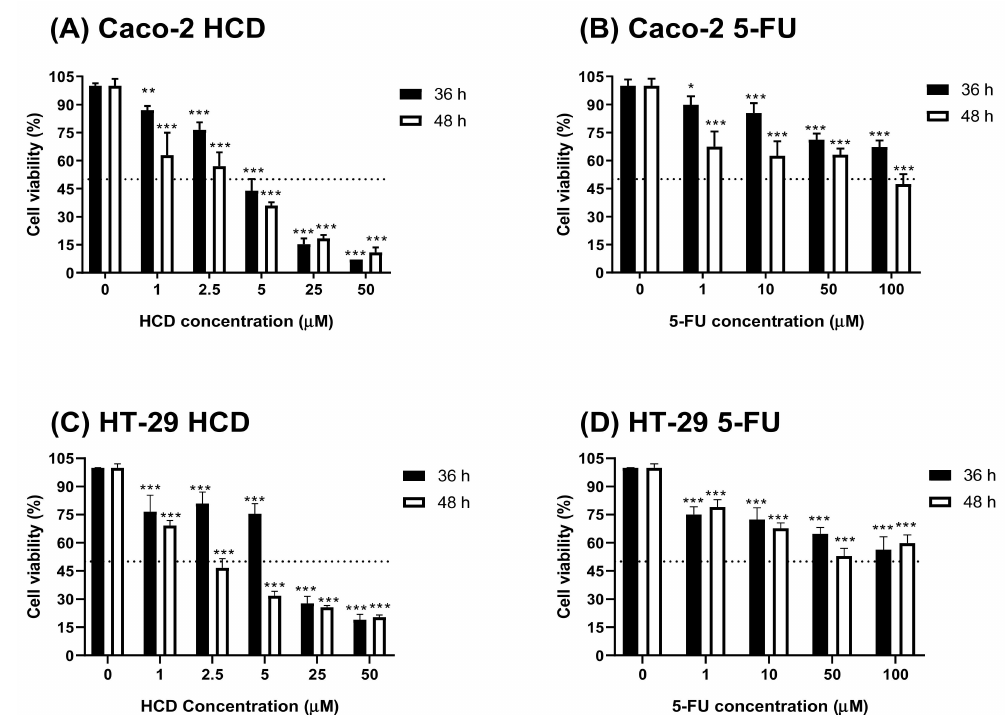
Figure 3. Cell viability of Caco-2 and HT-29 cells after HCD and 5-FU treatments. HCD and 5-FU were used to treat with ( A , B ) Caco-2 and ( C , D ) HT-29 cells for 36 and 48 h, respectively. The cell viability was determined by MTT assay. In addition, the cell viability was calculated according the comparison of control group (0 µ M). Data ( n = 3) were represented as mean ± SD. * p < 0.05; ** p < 0.01; *** p < 0.001, as compared with the untreated control (0 µ